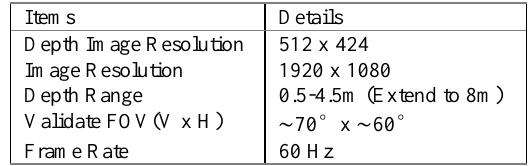
Table 1. Specification of Kinect v2